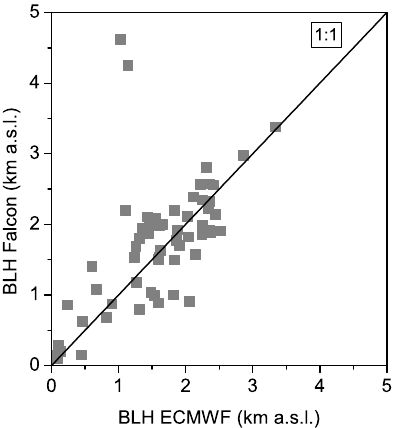
Fig. A2. Comparison of boundary layer height blh (kma.s.l.) from in-situ measurements of DLR Falcon 20 with ECMWF model anal- ysis